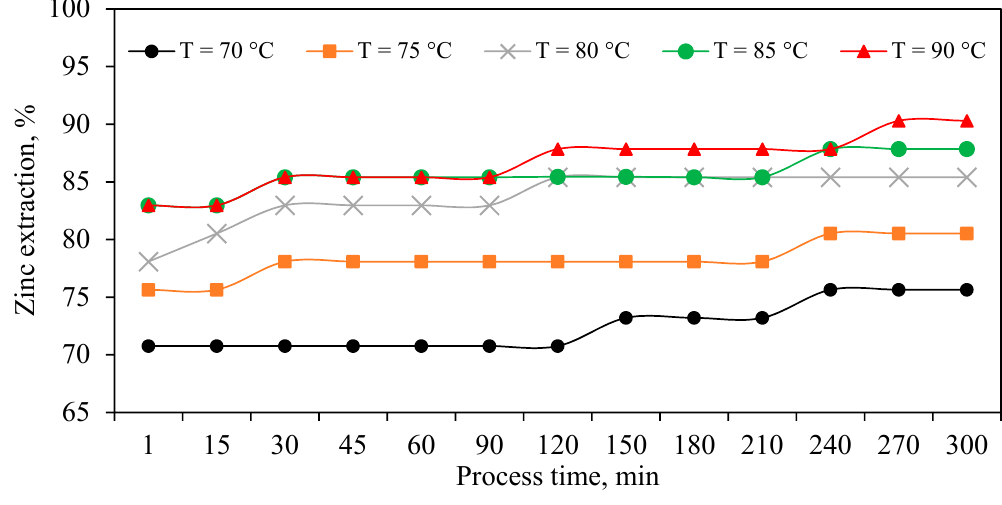
Figure 3. Zinc dissolution efficiency during leaching experiments.